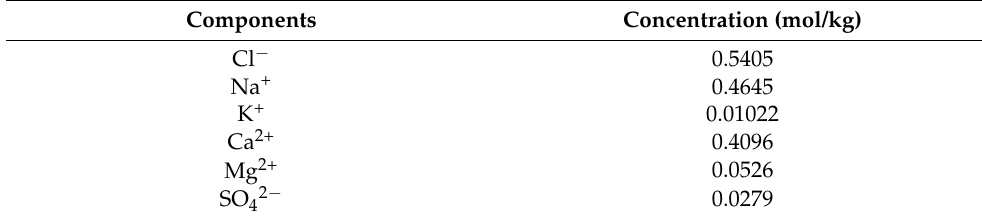
Table 10. Main components of seawater with a salinity of